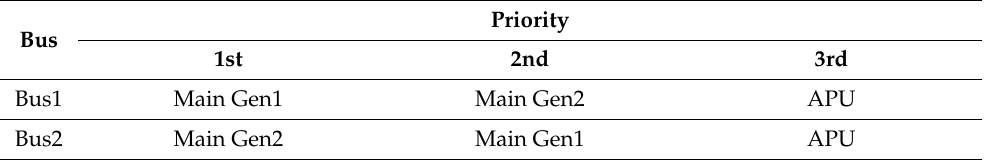
Table 1. Priority of connection between generator and